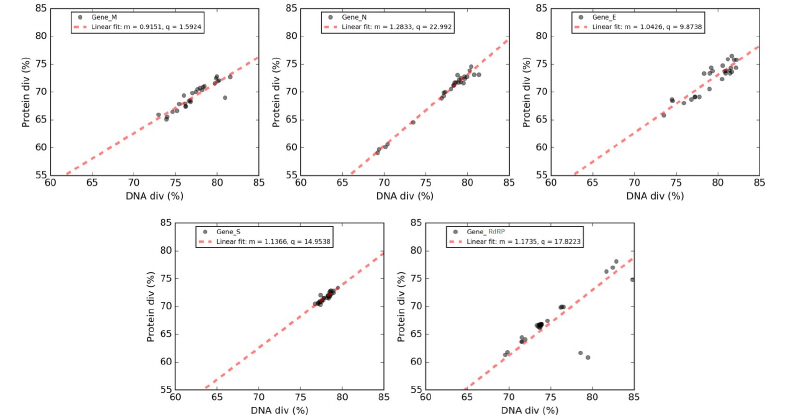
Figure 8. Forsdyke plots of genes M, N, S, E and RdRP . Phenotype (Protein div) vs. nucleotide (DNA div) sequence divergence between SARS-CoV-2 and orthologous genes in the other coronaviruses. Each point corresponds to an individual gene. In each panel, the best-fit line is shown in red, together with the associated values of the slope (m) and the intercept (q) in the